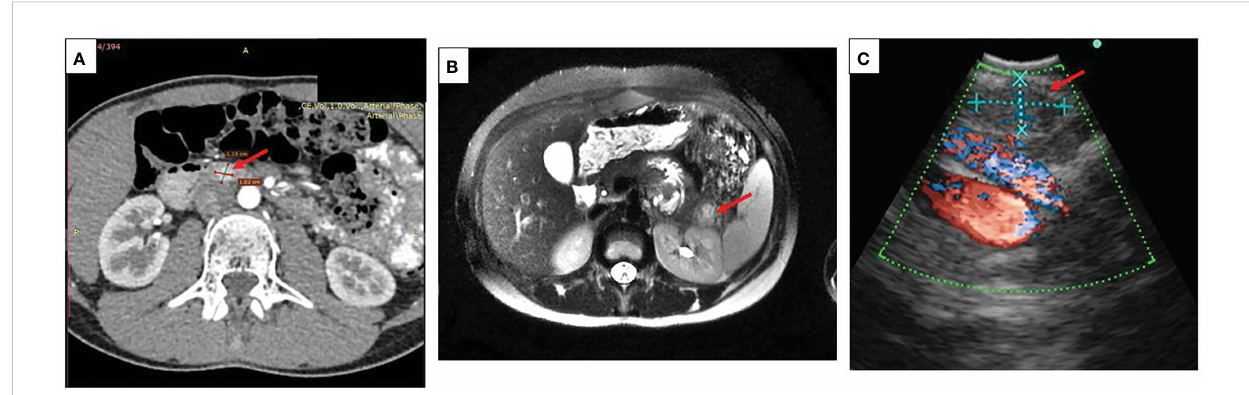
FIGURE 1 Imaging in pediatric patients with insulinoma (A) A representative CT scan showing insulinoma in the head of the pancreas (case #14), arrow indicating a round shaped hypervascular 1.5 cm lesion in the head of the pancreas highly enhanced during the arterial phase; (B) A representative contrast MRI scan showing an insulinoma in the pancreatic tail (case #8), arrow indicating a 2.3 cm lesion in the pancreatic tail with high signal intensity on T2 MR regimen; (C) A representative picture of endoscopic ultrasound localizing lesion in the pancreatic tail (case #13), arrow indicating a 0.9 cm ovoid shaped lesion, isoechoic with hypoechoic inclusions and distinct